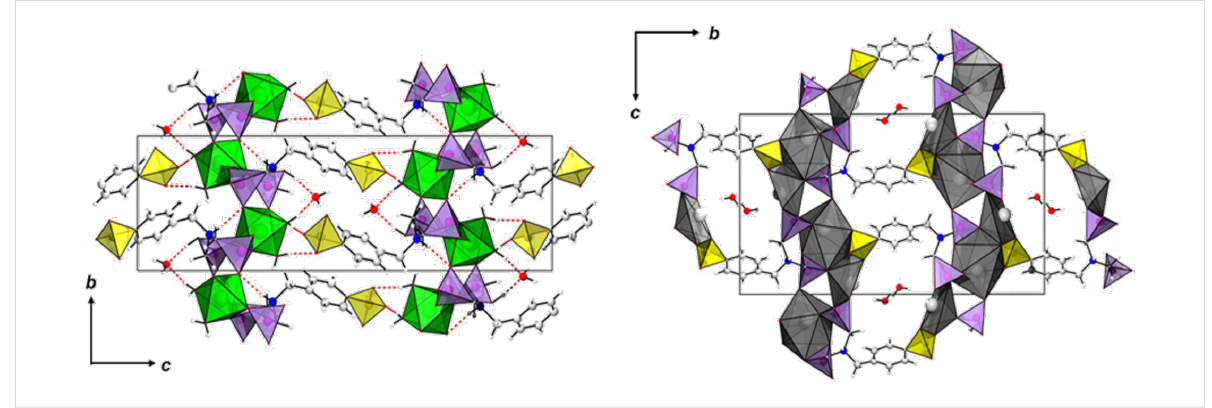
Figure 1: Crystal structures of [Mg(H 2 O) 2 (H 3 L)]·H 2 O) (left) and [Pb 2 (HL)]·H 2 O) (right). General color scheme: Mg: green octahedra, Pb: dark grey polyhedra, P: violet tetrahedra, S: yellow tetrahedra, C: light grey, N: blue, H: white, H bonds: red dotted lines.